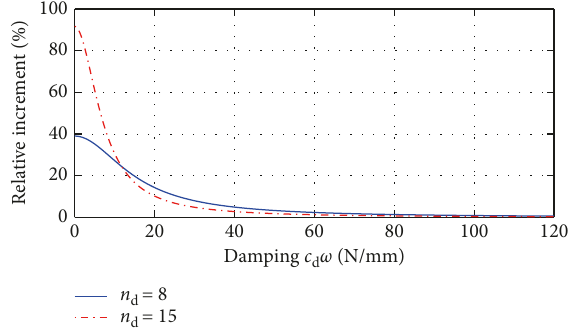
Figure 8: Relative increment of the additional damping ratio with � − 2 . 73 negative stiffness k d